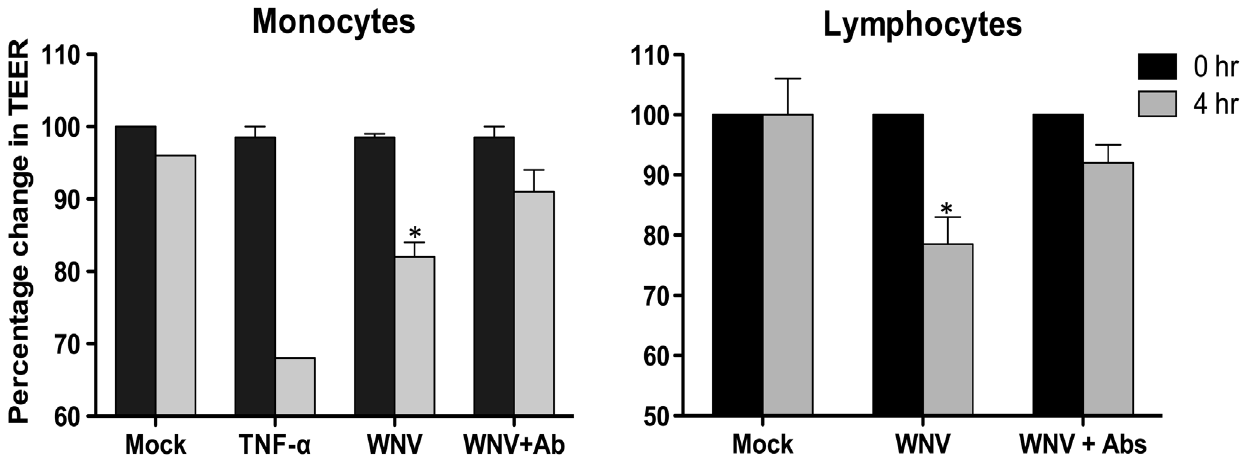
Figure 5. Neutralizing antibodies against cell adhesion molecules partially reverse the disruption of the invitro BBB model during leukocyte transmigration. The integrity of the in vitro BBB model was determined by measuring the TEER before and after four hrs of incubation with monocytes and lymphocytes in the presence or absence of the cocktail of neutralizing antibodies against CAMs. The decrease in the TEER values was represented as percentage change as compared to mock-infected controls. The data is mean 6 SD of two independent experiments. *p , 0.05 compared to mock.